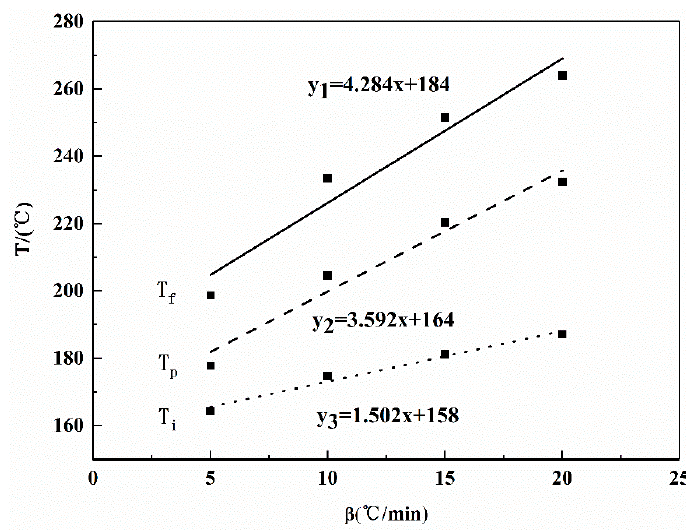
Figure 16. Extrapolation diagram of the curing reaction temperature at a zero heating rate for the EHTPB-IPDI-DBTDL system. Table 6. Initial, Peak and Final temperatures of EHTPB-IPDI-TECH and EHTPB-IPDI-DBTDL.